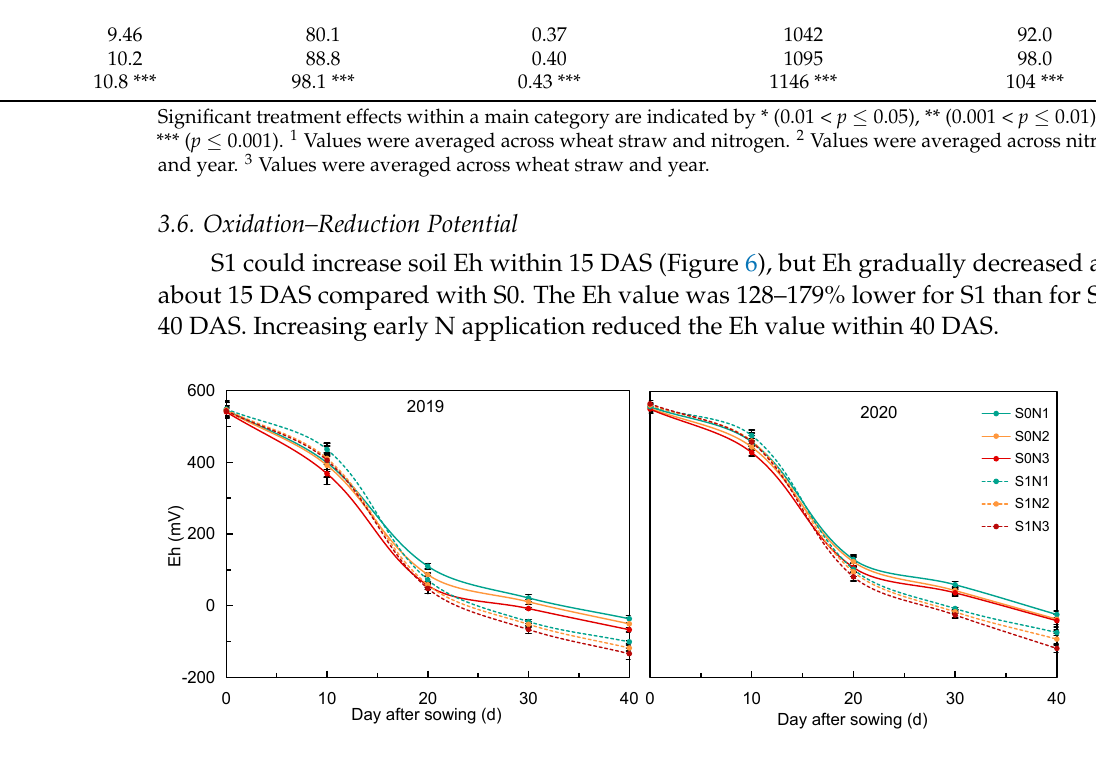
Figure 6. The oxidation–reduction potential (Eh) during 40 day after sowing under wheat straw returning coupled with early N management in 2019 and 2020. S0 and S1 represent treatment without wheat straw returning and treatment with wheat straw returning, respectively. N1, N2, and N3 represent early N management of 65 kg N ha − 1 , 95 kg N ha − 1 , and 125 kg N ha − 1 , respectively. The information on these treatments was shown in Table 1. Error bars show standard error of replicates ( n = 3).